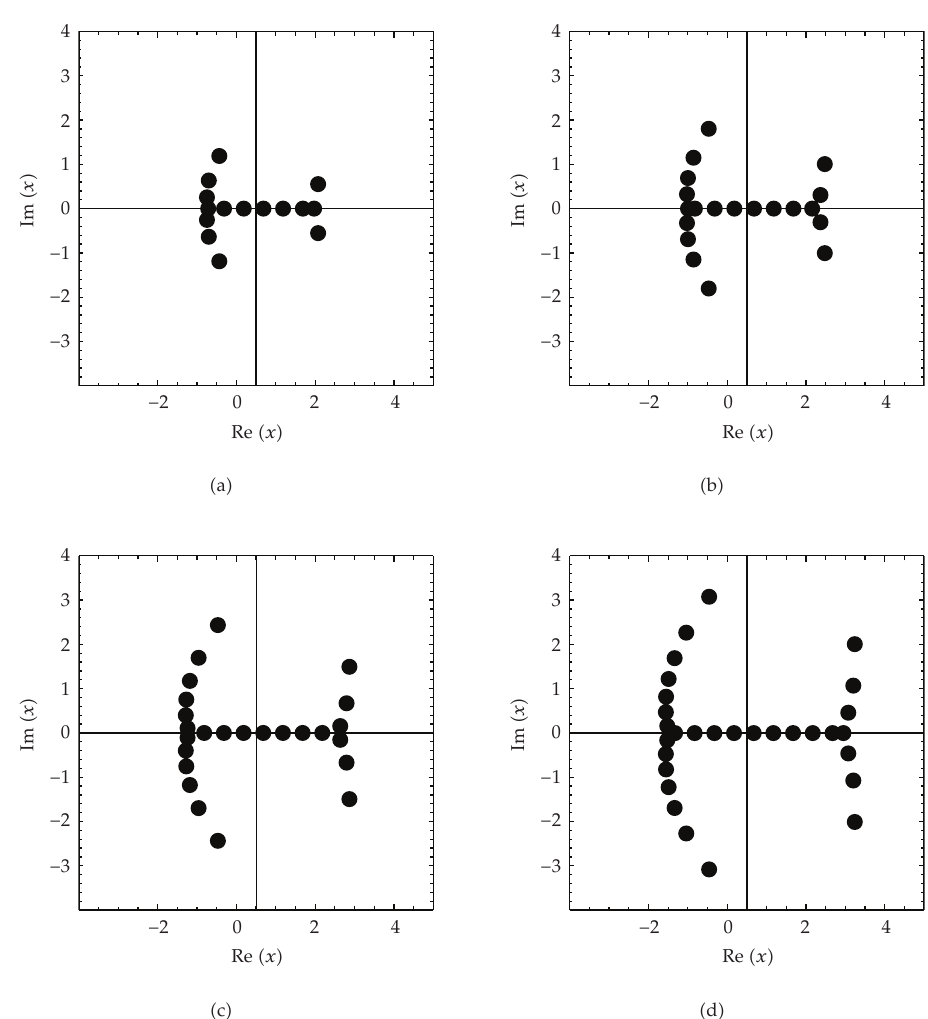
(cid:2) 3 (cid:3) (cid:2) x (cid:3) for n (cid:6) 15 , 20 , 25 , n, 1 / 2